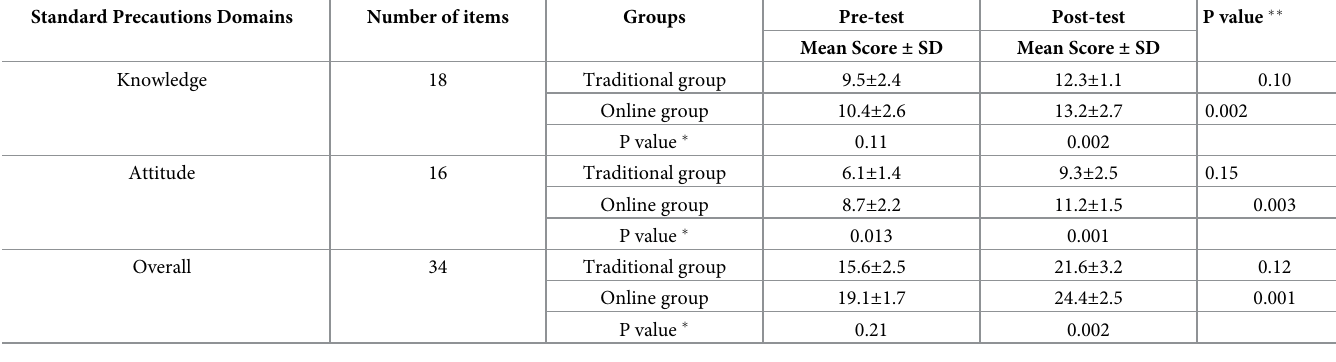
Table 2. Comparison of standard precautions knowledge and attitude means scores of the traditional lecture and the online education groups. Standard Precautions